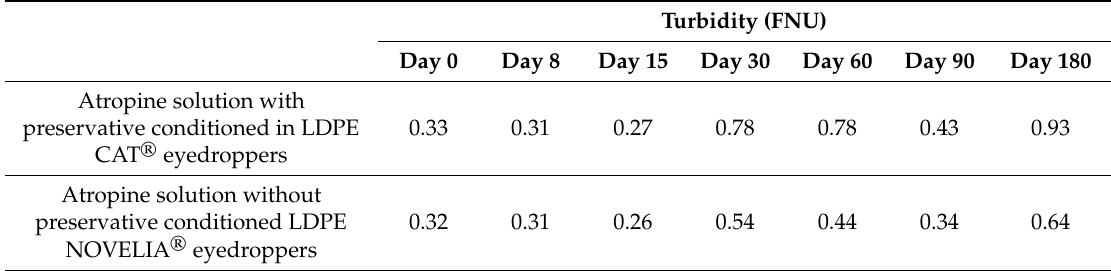
Table 4. Evolution of turbidity over time. n = 1 (pooled volume from 5 units). FNU: Formazin Nephelometric Units.